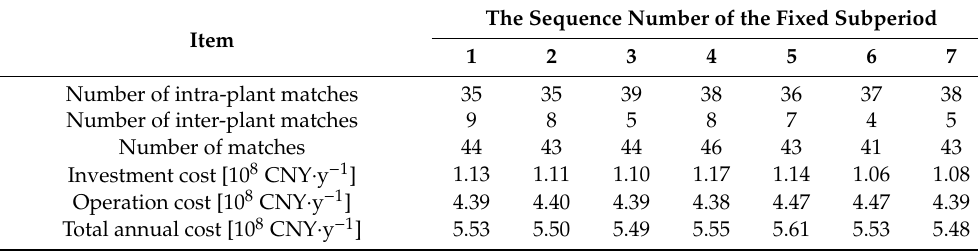
Table 5. Costs and the number of matches for the scheme obtained by the structure-fixed method. The Sequence Number of the Fixed Subperiod Item